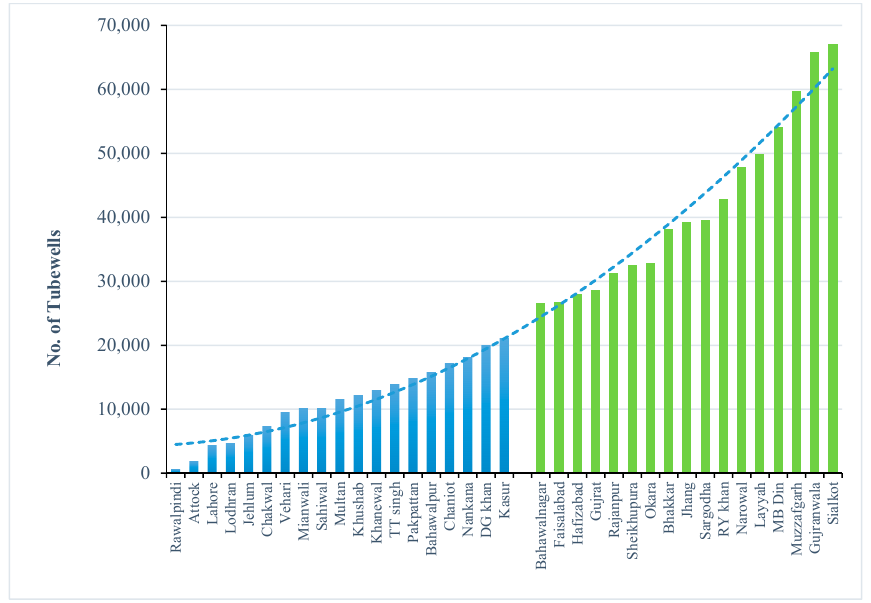
Figure 3. Number of tubewells in different districts in the Punjab Province of Pakistan (Source: Punjab Agricultural Statistical Department).